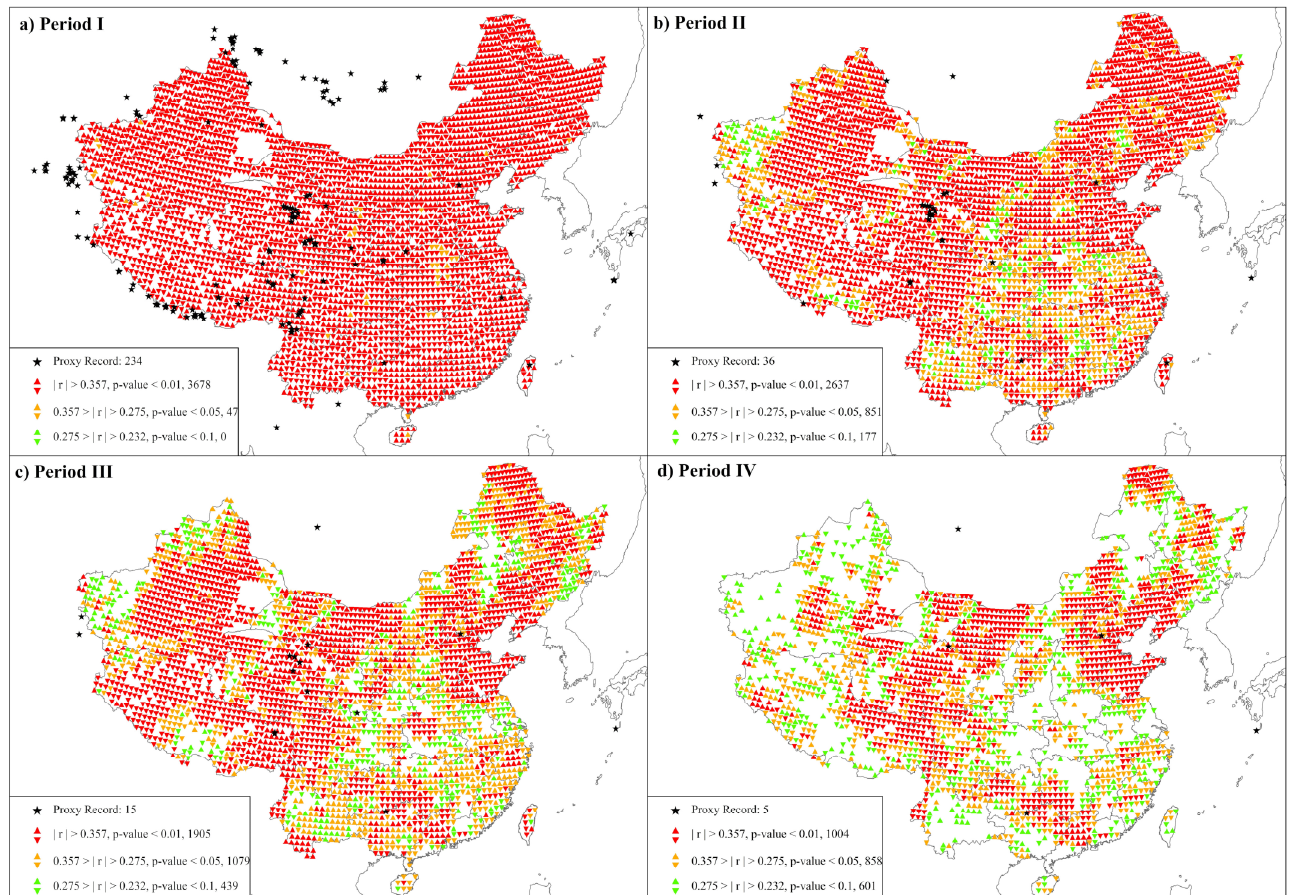
Figure 4. Results of Pearson correlation analysis of four reconstruction periods between proxy records and scPDSI (0.5° × 0.5° resolution). The normal triangle represents a significant positive correlation, while the inverted triangle represents a significant negative correlation.